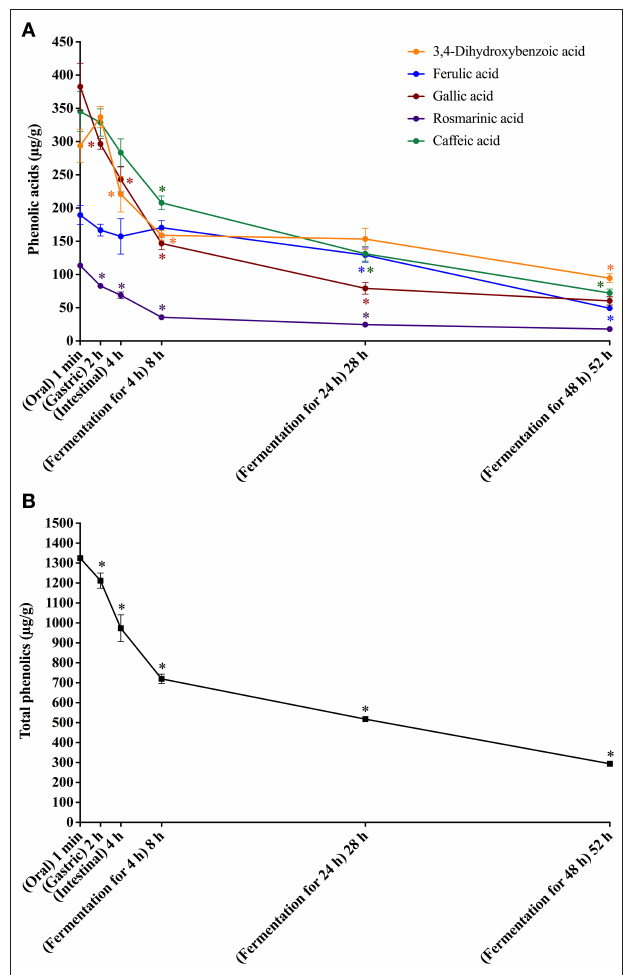
FIGURE 2 | In vitro simulated digestion (oral, gastric and intestinal steps) and gut fermentation of bread free phenolic compounds: phenolic acids (A) and total phenolics (B) . The asterisk indicates a significant difference in relation to the previous step (ANOVA followed by Tukey’s post-test, p < 0.05).